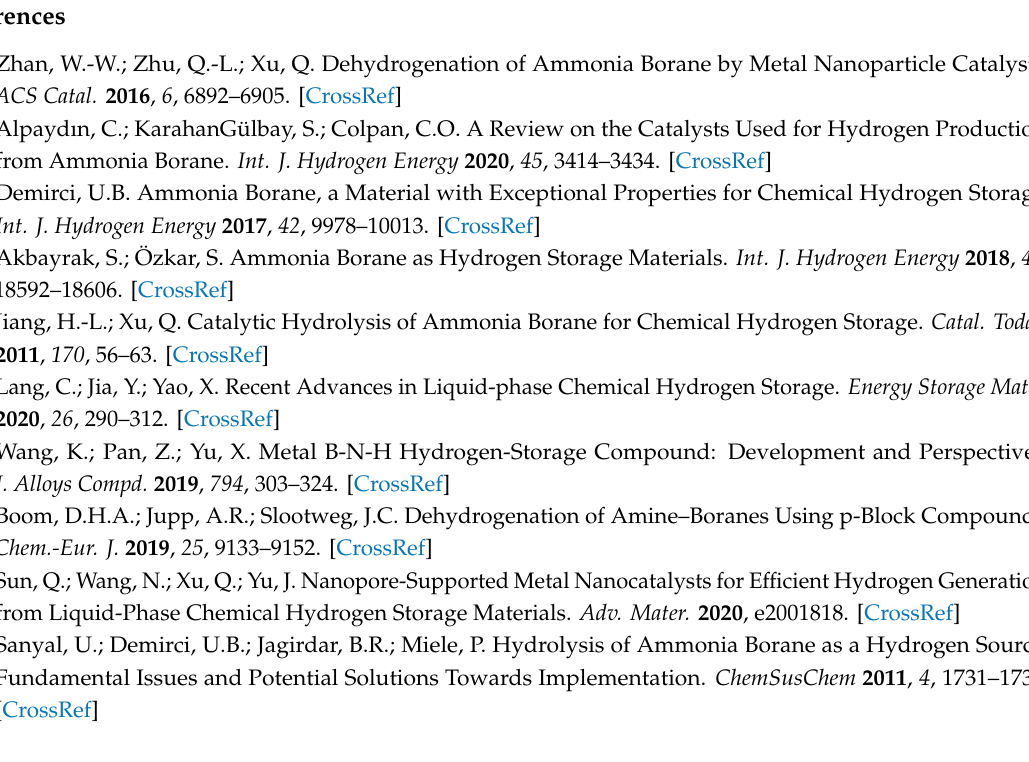
Figure S1: EDS mapping images of Cu@Pd 0.75 / C-320, Figure S2: EDS mapping images of Cu@Pd 1.0 / C-320, Figure S3: EDS mapping images of Cu@Pd 2.0 / C-320, Figure S4: EDS mapping images of Cu@Pd 0.5 / C-320-R, Figures S5 and S6: Plots of hydrogen evolution from ammonia borane vs. time on Cu@Pd / C-320 at 298 K (a), 303 K (b), 308 K (c), 313 K (d) and the corresponding Arrhenius plot (e), Figures S7 and S8: Plots of hydrogen evolution from ammonia borane vs. time on PdCu / C at 298 K (a), 303 K (b), 308 K (c), 313 K (d), and the corresponding Arrhenius plot (e), Figure S9: Plots of hydrogen evolution from ammonia borane vs. time over Cu@Pd / C prepared from Cu / C with di ff erent oxidation degree, Figure S10: The stability test of Cu@Pd0.5 / -320, Figure S11: Survey XPS spectra of PdCu / C and Cu@Pd / C, Figure S12: Survey XPS spectra of Cu / C, Figure S13: The HRTEM image of Cu@Pd 0.5 / C-320-R, Figure S14: TEM image of Cu@Pd 0.5 / C-320-R, Figure S15: The schematic diagram of apparatus for catalytic hydrolysis of AB, Table S1: The content of Pd and Cu in the sample determined by